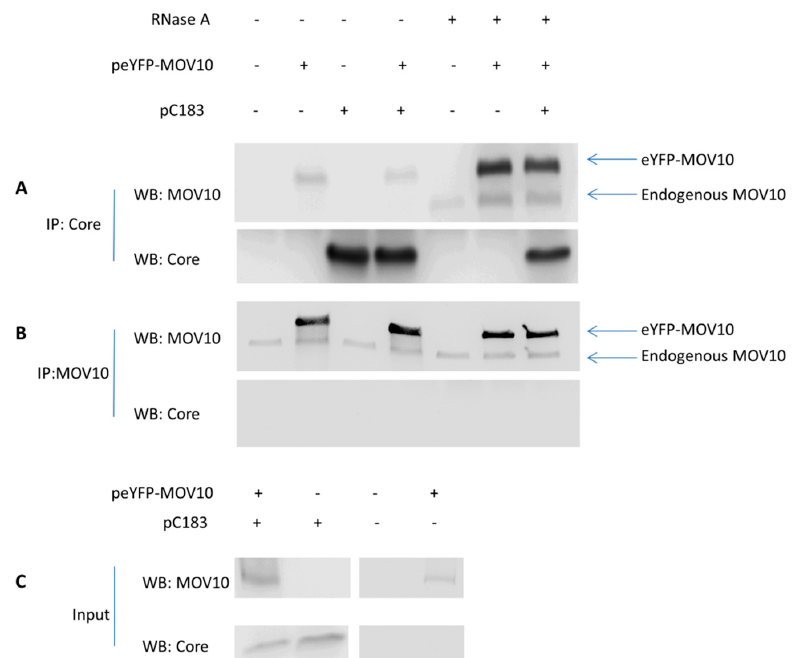
Figure 7. No specific interaction between MOV10 and HBV core protein. 293T cells were transfected with pC183 and peYFP-MOV10, pC183 and peYFP-empty, peYFP-MOV10 and peYFP-empty, or peYFP-empty only. Where indicated, lysates were pre-treated with RNase A prior to immunoprecipitation with the indicated antibodies. Immunoprecipitates were analyzed by western blotting using the indicated antibodies. ( A ) Proteins in lysates were immunoprecipitated with the anti-HBV core antibody. Immunoprecipitates were analyzed by western blotting using the anti-MOV10 and anti-HBV core antibodies. ( B ) Proteins in lysates were immunoprecipitated with the anti-MOV10 antibody. Immunoprecipitates were analyzed by western blotting using anti-MOV10 and anti-HBV core antibodies. ( C ) Western blotting showing detectable levels of MOV10 and HBV core proteins in tested lysates.